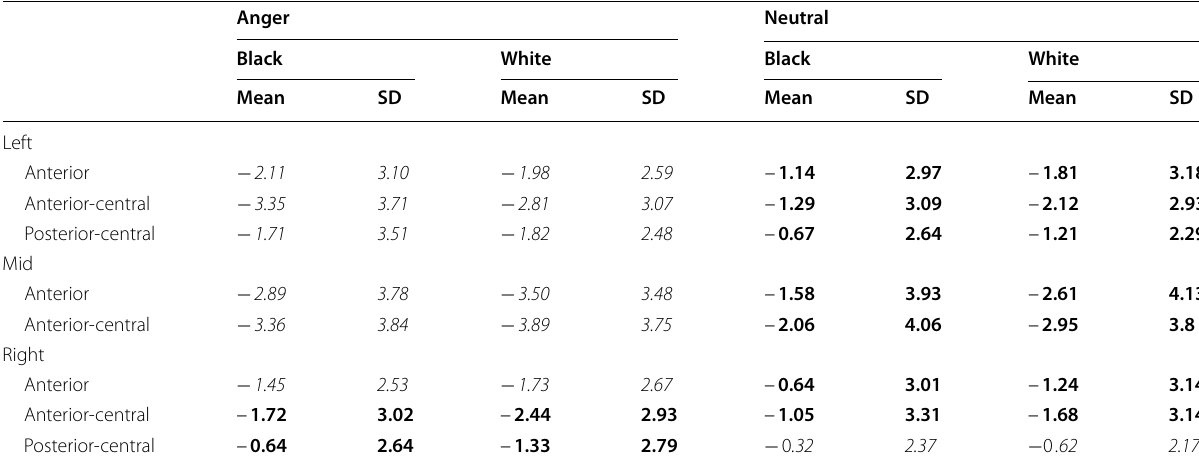
Table 5 Mean N2 amplitude by Emotion and Race